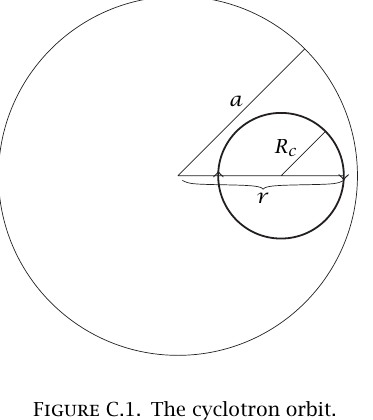
Figure C.1 . The cyclotron